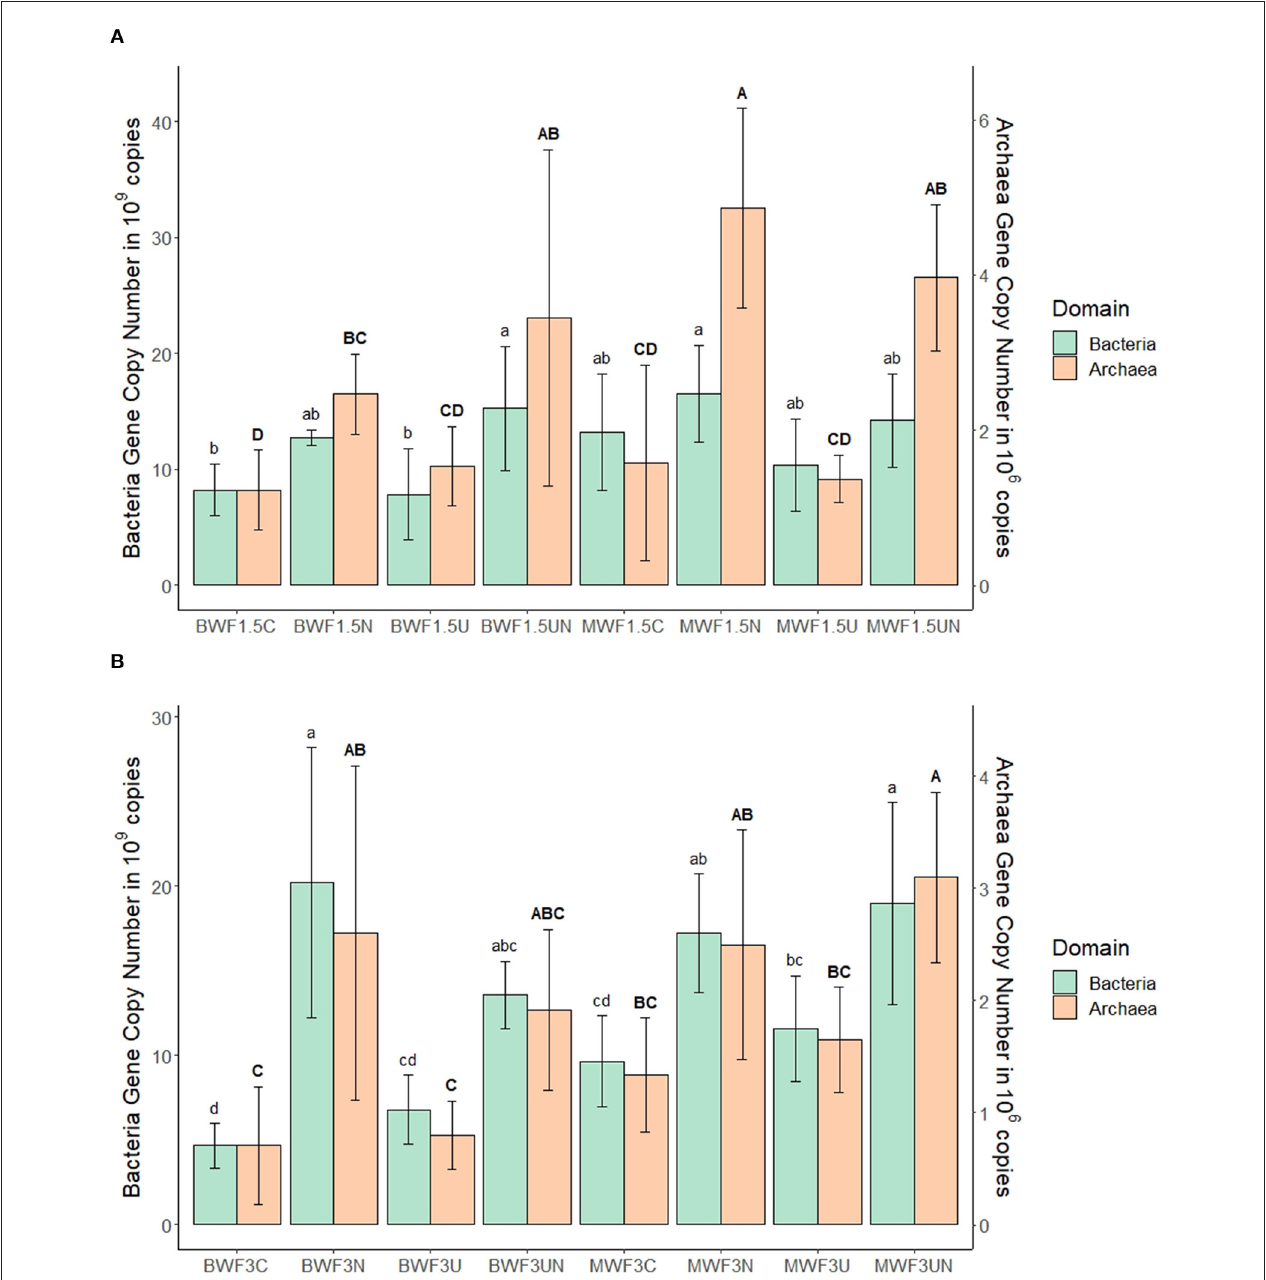
FIGURE 3 | Mean 16S rRNA gene copy numbers of bacteria (standard letters) and archaea (capital letters) per gram of soil at the end of the experiment after (A) 1.5% frass addition with plants and (B) 3.0% frass addition without plants (mean ± 95% confidence interval for n = 5). Pots were amended with frass alone, or concurrently with nitrification inhibitor (NI), urease inhibitor (UI), or both. For each microbial domain, different letters indicate significant differences between the means of the treatments ( p <